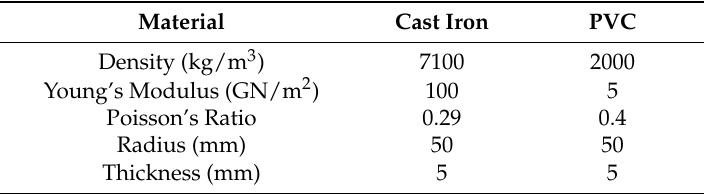
Table 1. Properties of the cast iron and polyethylene (PE) pipes.